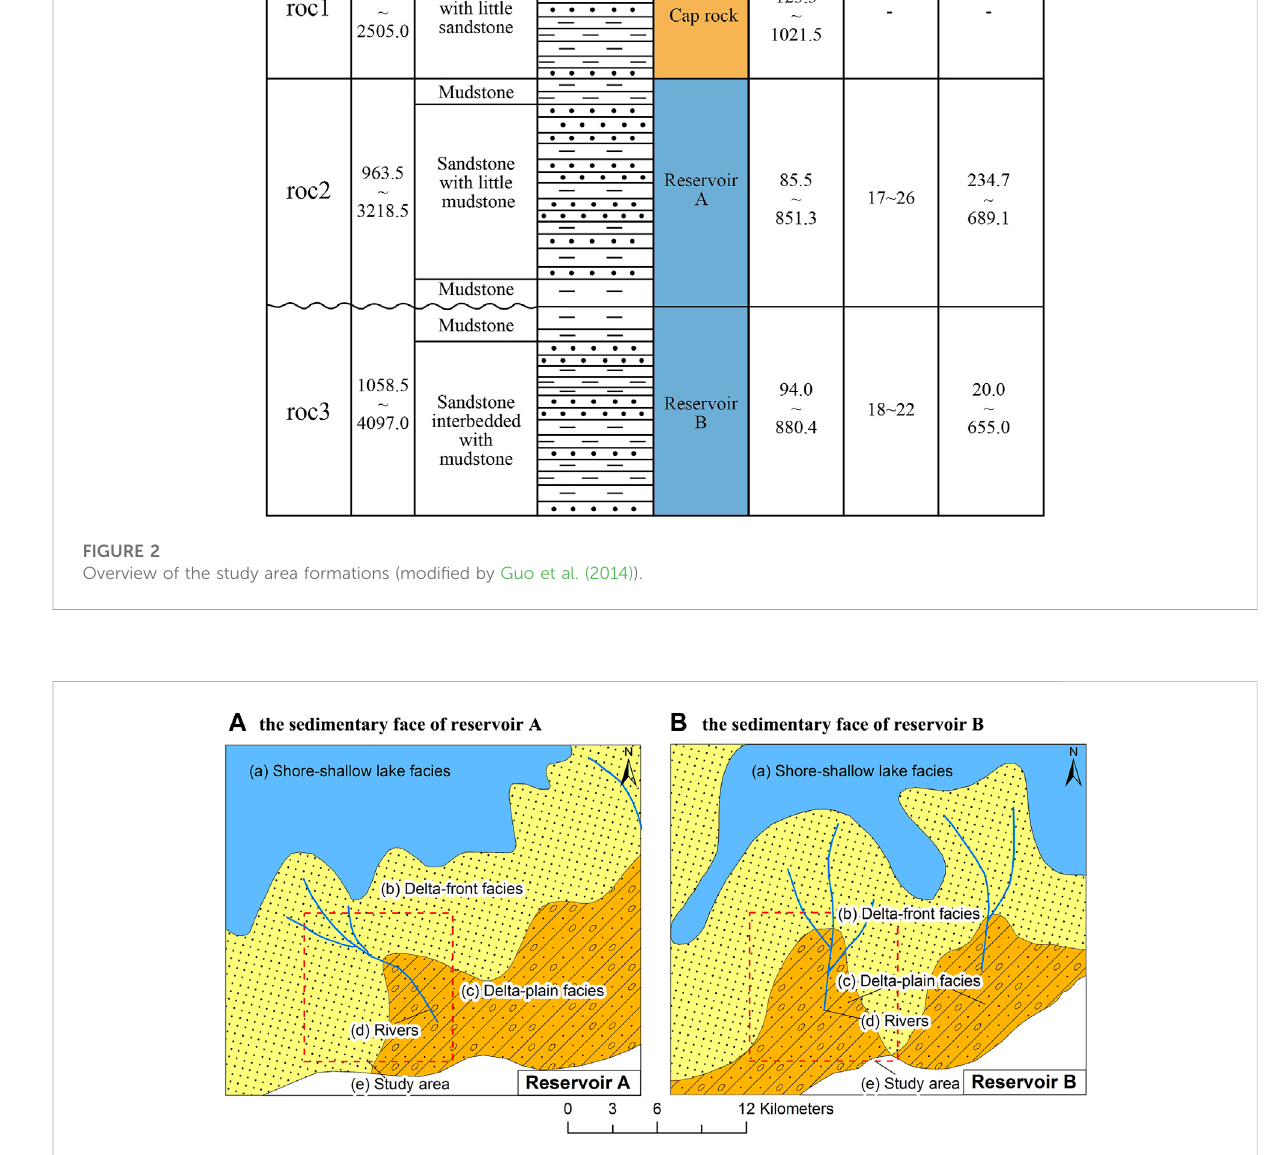
FIGURE 3 Sedimentary facies maps of the study area (Original data from Reference (Wang,